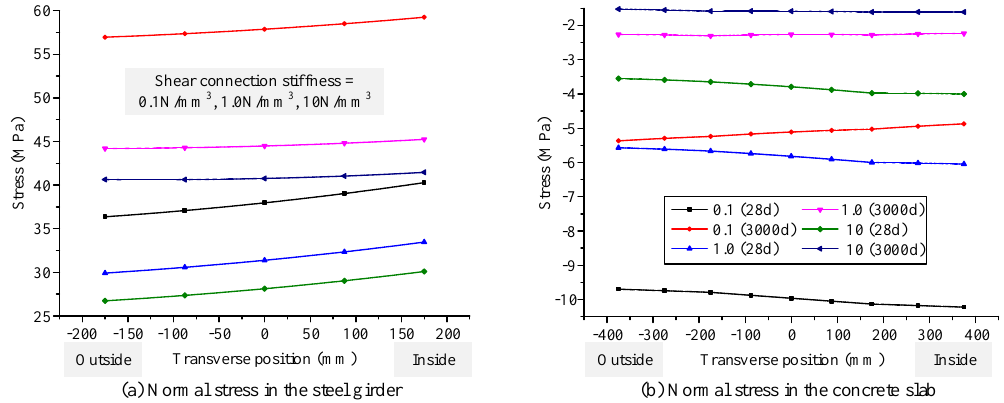
Figure 12. Normal stress distribution along the transverse direction of the curved composite box girder at the initial and ultimate loading ages for different interfacial shear connection stiffness: ( a ) normal stress in the steel girder, ( b ) normal stress in the concrete slab.